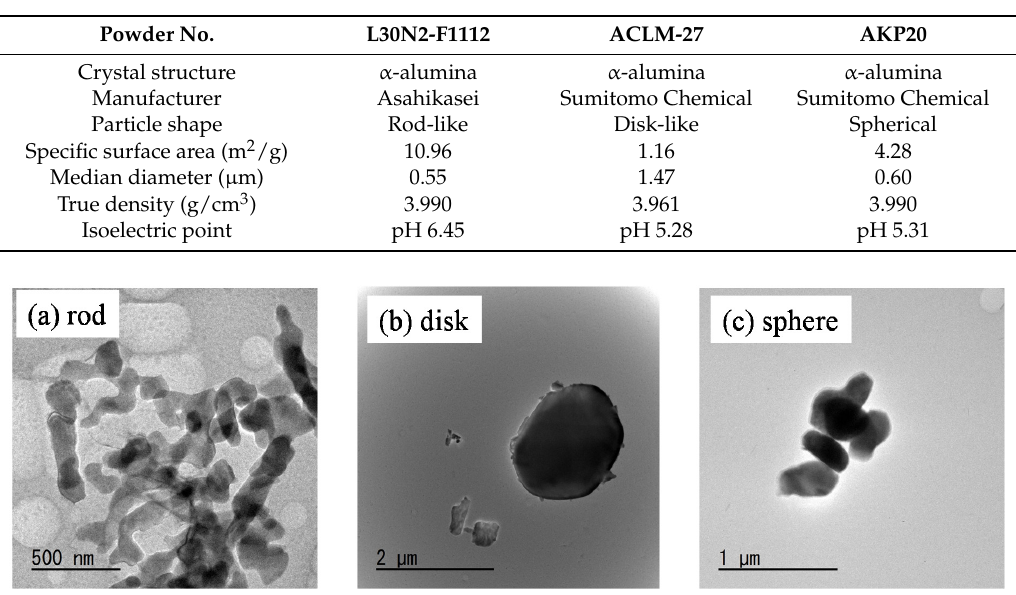
Figure 1. Particle morphology of ( a ) rod ‐ like alumina, ( b ) disk ‐ like alumina and ( c ) spherical